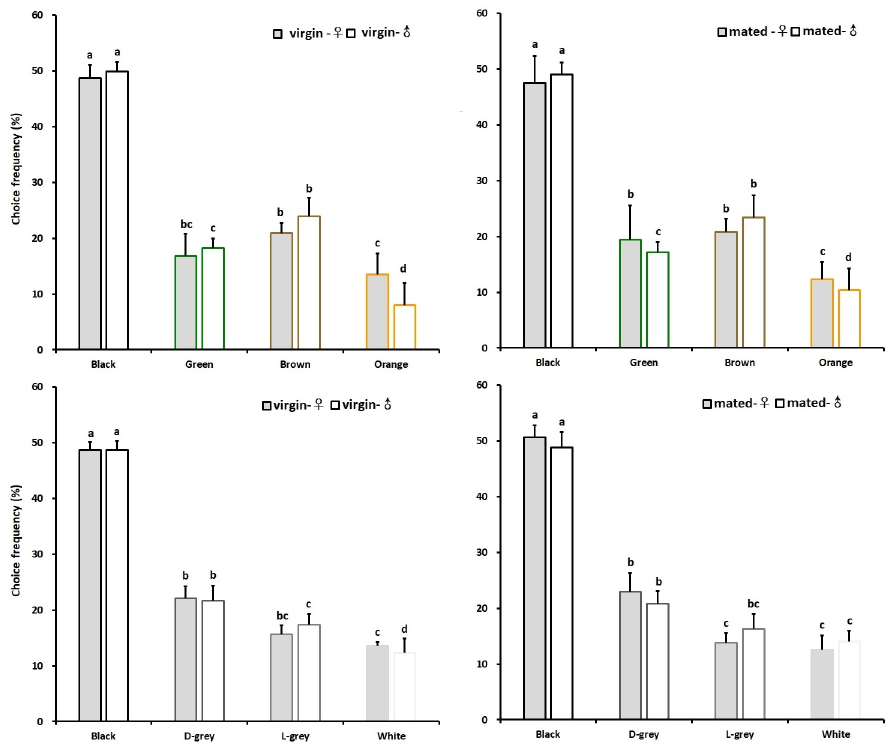
Fig 6. Colour and brightness preference of chive gnat Bradysia odoriphaga adults with different physiological states. Different letters refer to significant differences according to One-way ANOVA with P < 0.05.